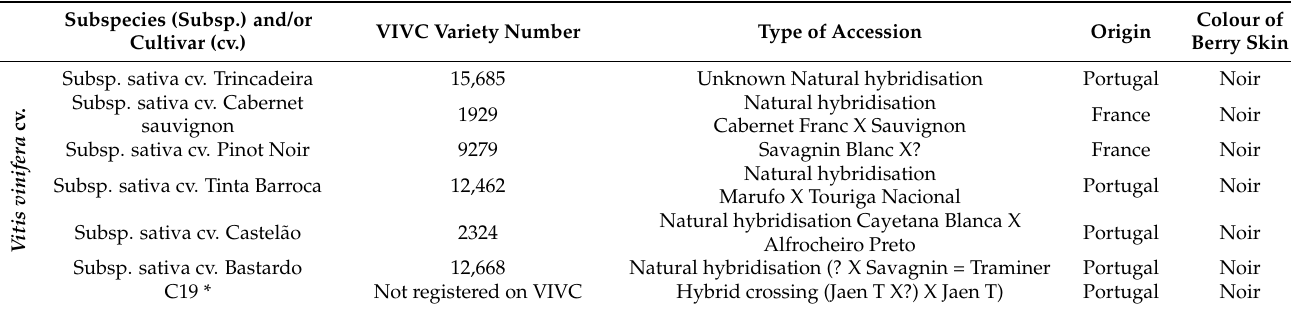
Table 1. Vitis vinifera cultivars selected for analyses. Species and cultivar names, VIVC variety number, type of accession, origin and colour of berry